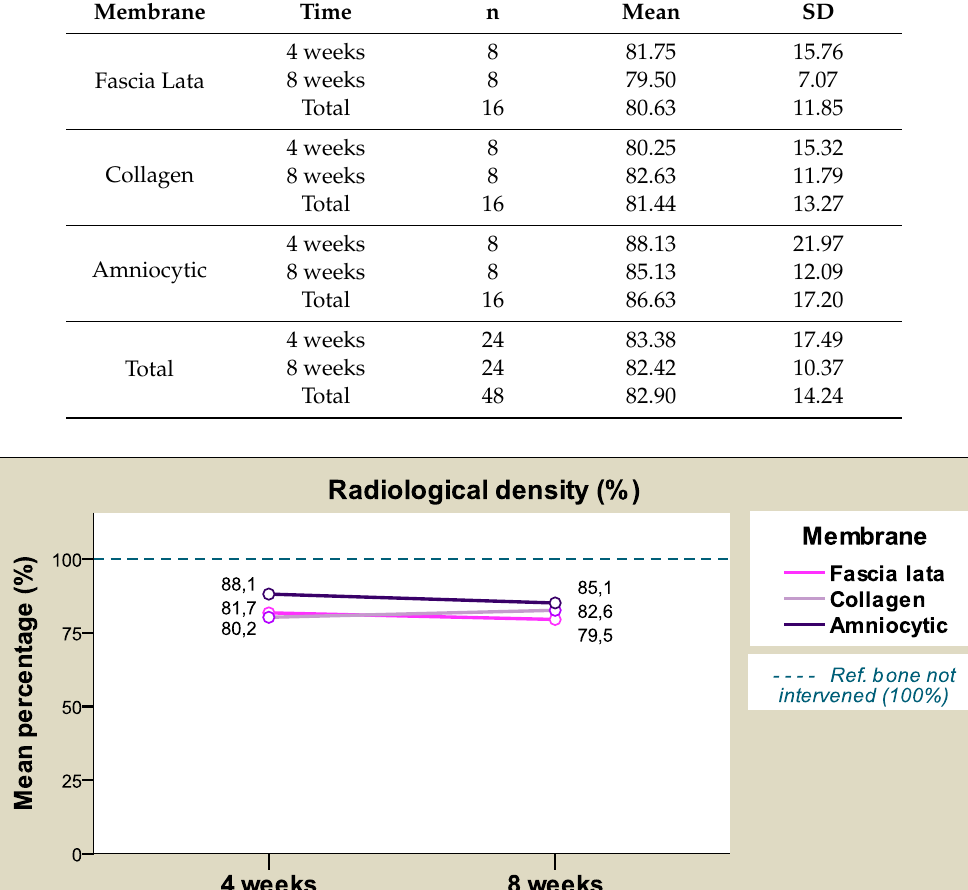
Table 8. The descriptive statistical values of differences in radiological density percentages: Case count (n); Mean (%) and standard deviation (SD) according to the membrane and stage.